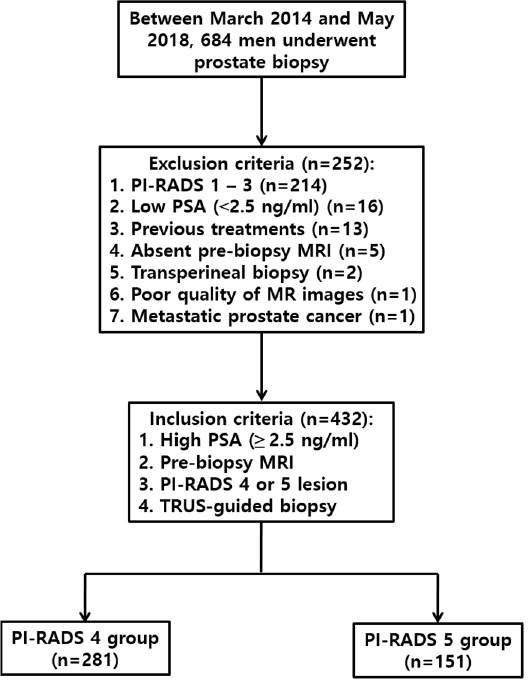
Figure 1. Flow diagram of the study population. Table 1. Patient demographics.